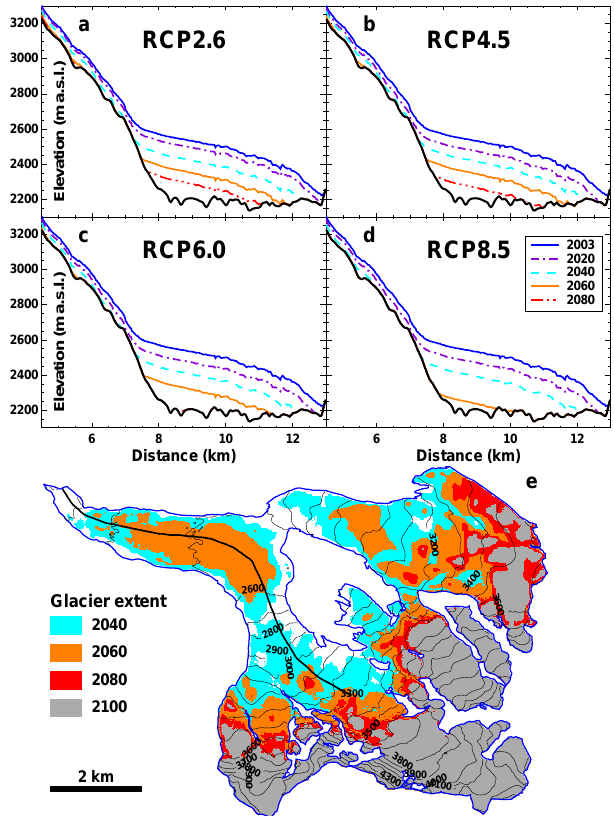
Fig. 4. Example of simulated future geometry changes of Gorner- gletscher, southwestern Switzerland, the second largest glacier in the European Alps. (a–d) Modelled glacier surface elevation in lon- gitudinal profiles (solid line in e ) of the glacier tongue. Glacier change is simulated using the Beijing Climate Center (bcc-csm1- 1) GCM driven by four RCPs. Results of bcc-csm1-1 correspond to the ensemble median. (e) Spatial changes in glacier size (RCP6.0). Contours refer to the glacier surface in